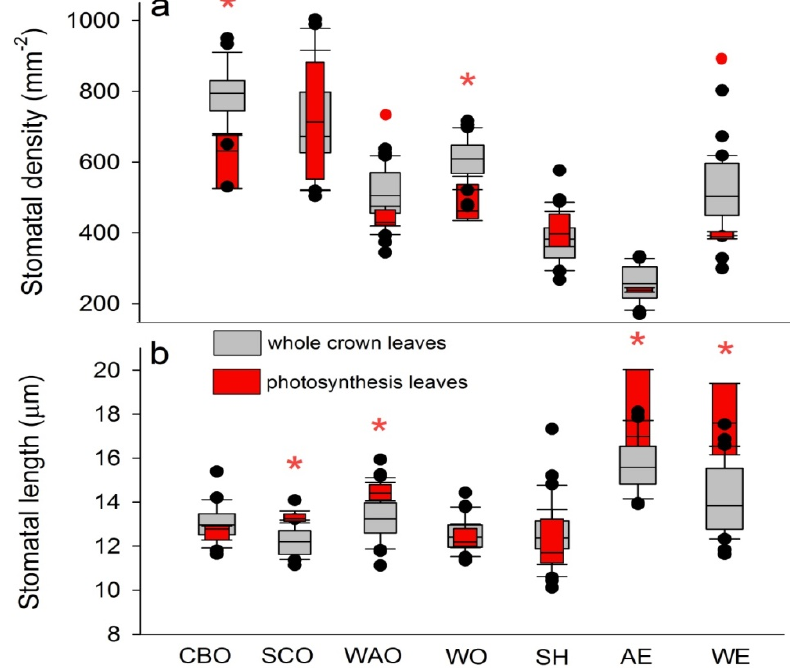
Figure 5. Boxplots of ( a ) mean stomatal densities (mm − 2 ) and ( b ) mean stomatal lengths ( µ m) from leaves collected from throughout the crowns of study individuals ( n = 30; gray boxes) and from leaves measured for photosynthetic gas exchange ( n = 3–5; red boxes). Red asterisks indicate that gas exchange (photosynthesis) leaves di ff ered significantly from whole-crown collections at P < 0.05; red dots indicate significant di ff erences at P < 0.1. Leaves were not collected from green ash whole crowns due to the di ffi culty in obtaining epidermal impressions.